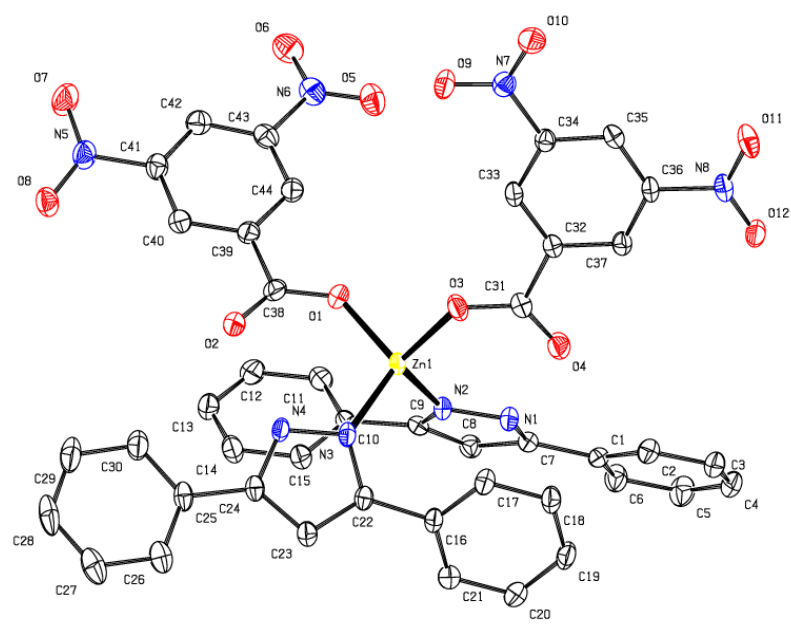
Figure 1. ORTEP diagram of complex 2 . All H atoms are omitted for clarity. Selected bond lengths (Å ) and bond angles (°): O(1)–Zn(1), 1.9327(15); O(3)–Zn(1), 1.9509(15); N(3)–Zn(1), 1.9968(17); N(2)–Zn(1),